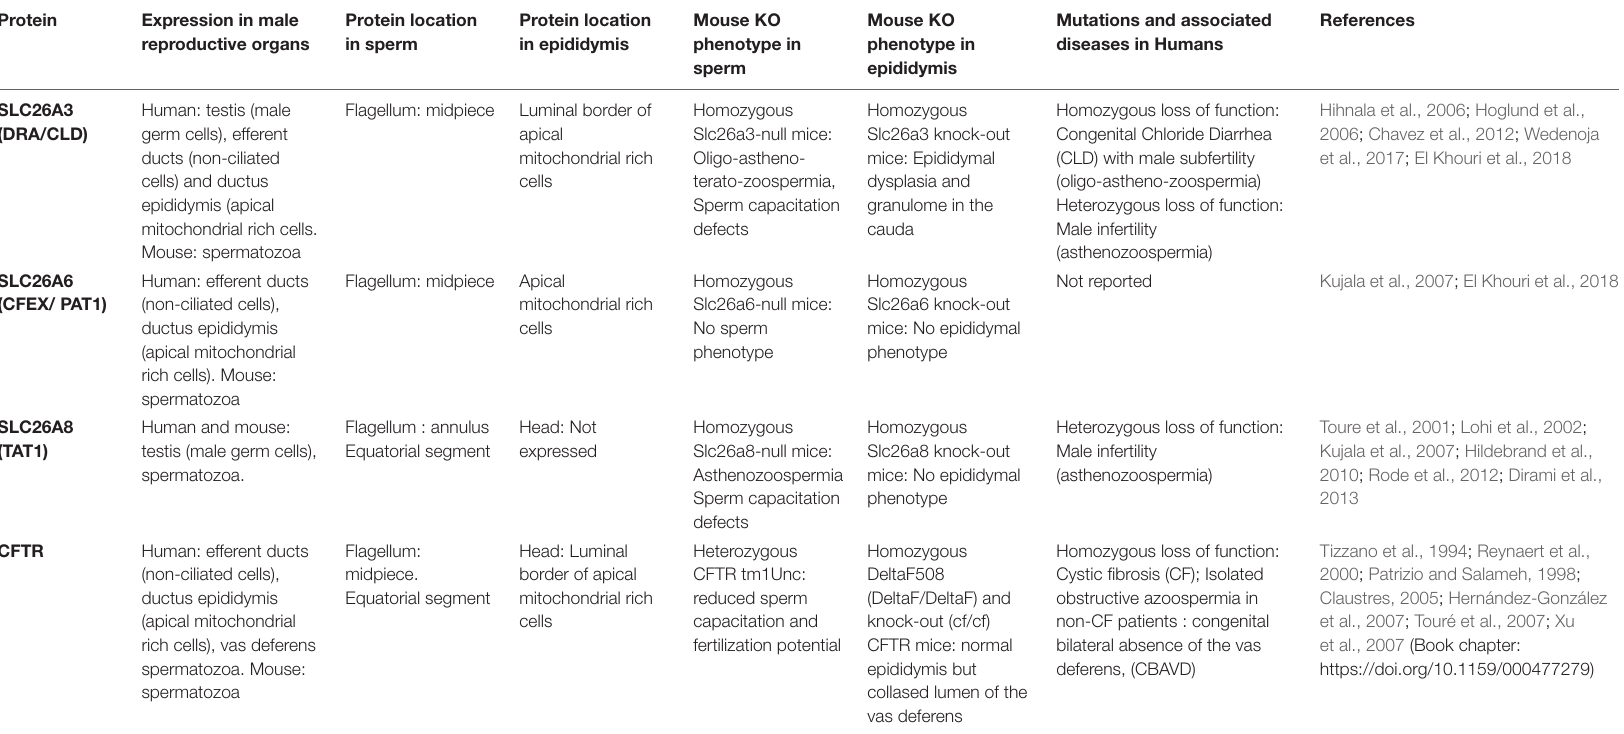
The table summarizes the tissues within the male reproductive organs where SLC26A3, A6, A8, and CFTR genes are expressed and the detection of the corresponding proteins in sperm and epididymal cells. The sperm and epididymal phenotypes in the mouse knock out mouse models are reported together with the phenotype associated with mutations in those genes in humans. References for information summarized in the table are